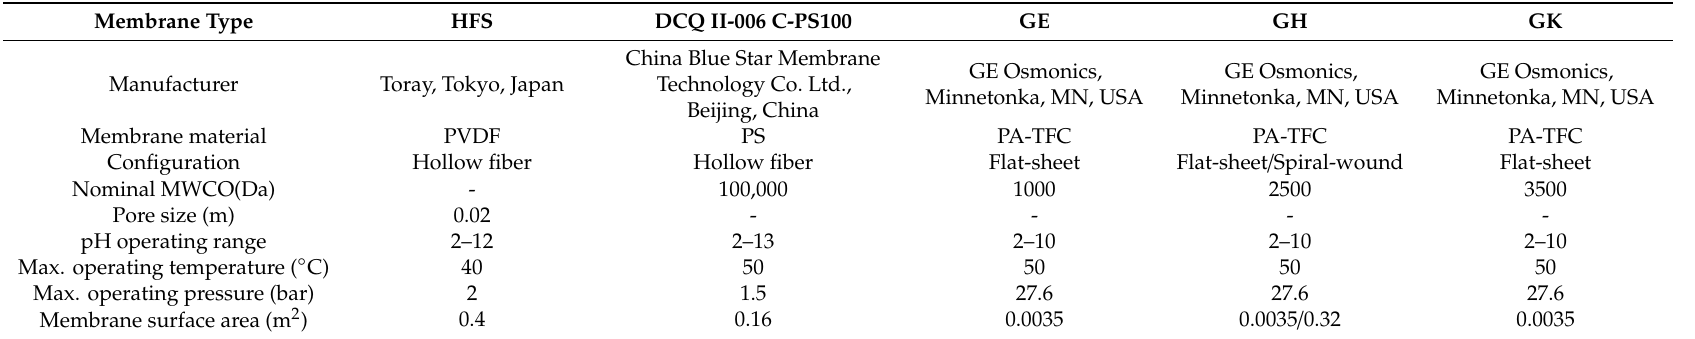
Table 4. Characteristics of selected